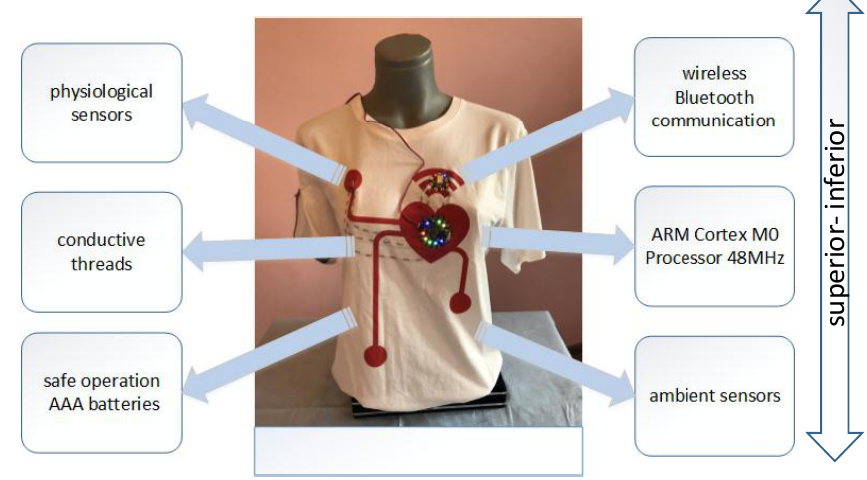
Figure 3. The system prototype.